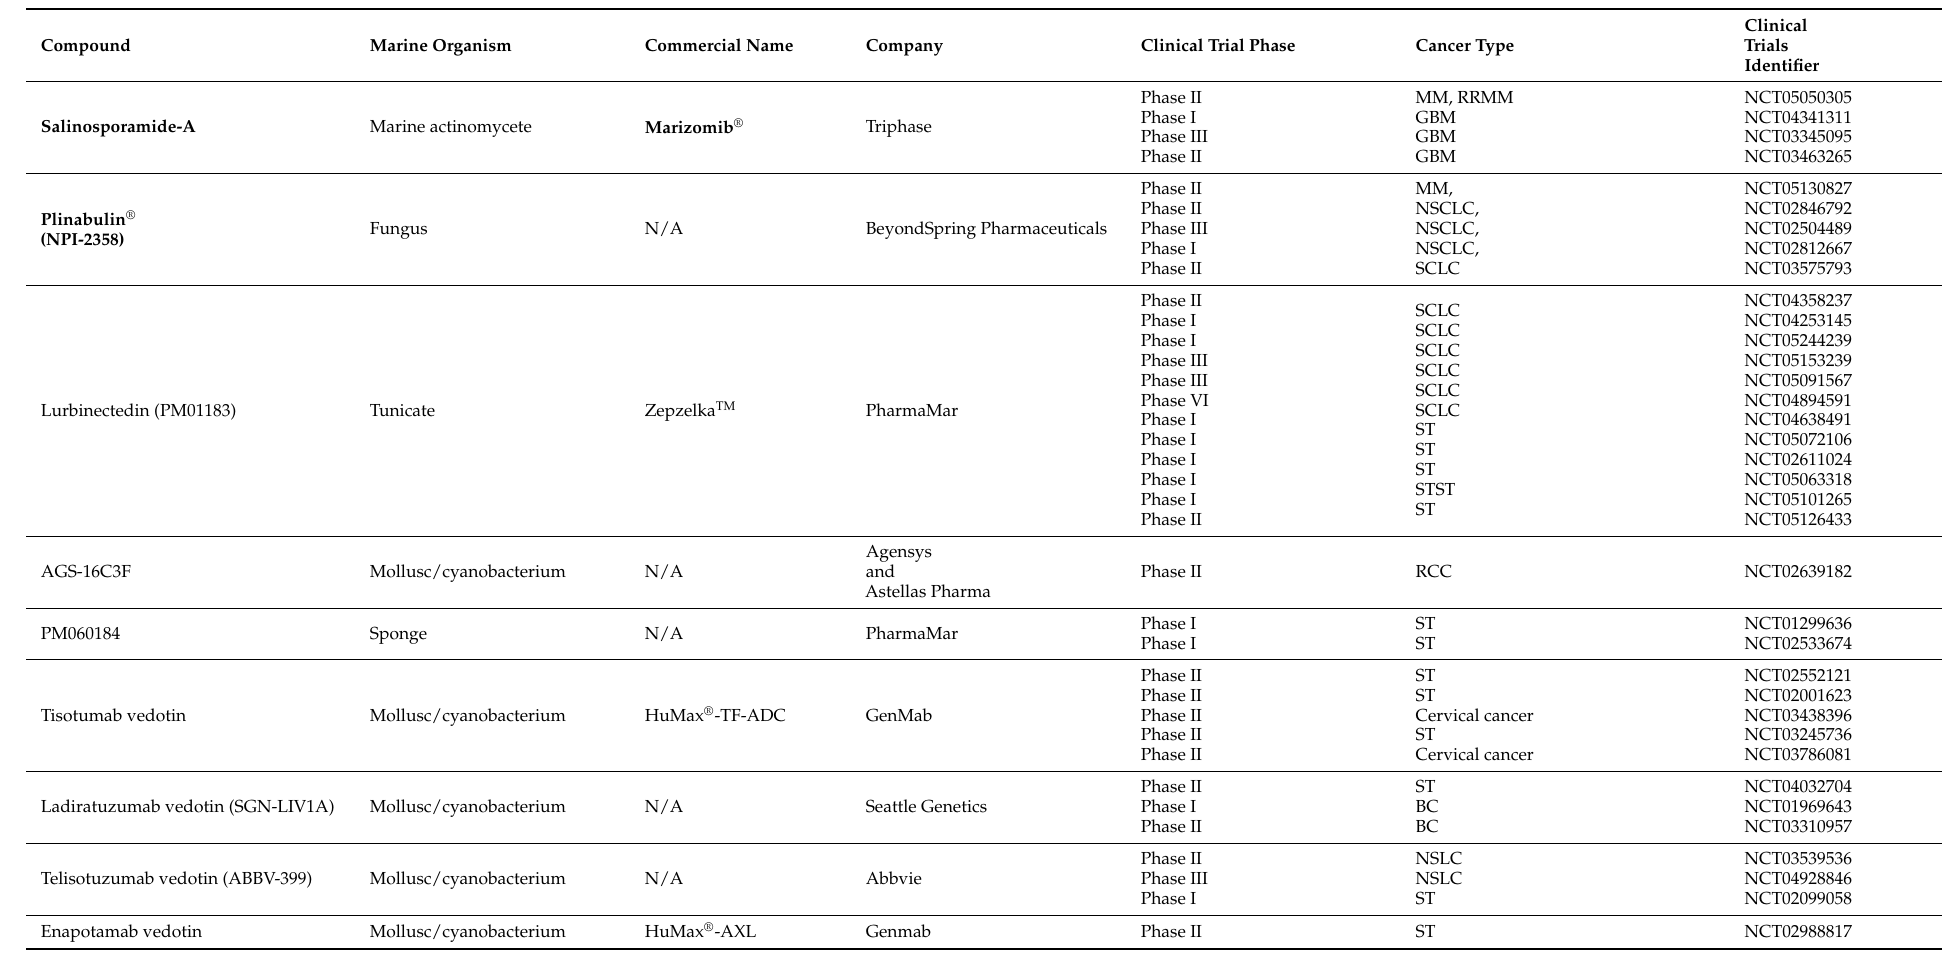
Table 2. Marine-derived drugs under clinical trial evaluation. Commercial name (when available), manufacturing company, clinical trial phase, cancer type and clinical trials identifier [48] are reported for each compound. Compounds in clinical trials for MM are in bold. NSCLC, nonsmall-cell lung carcinoma;